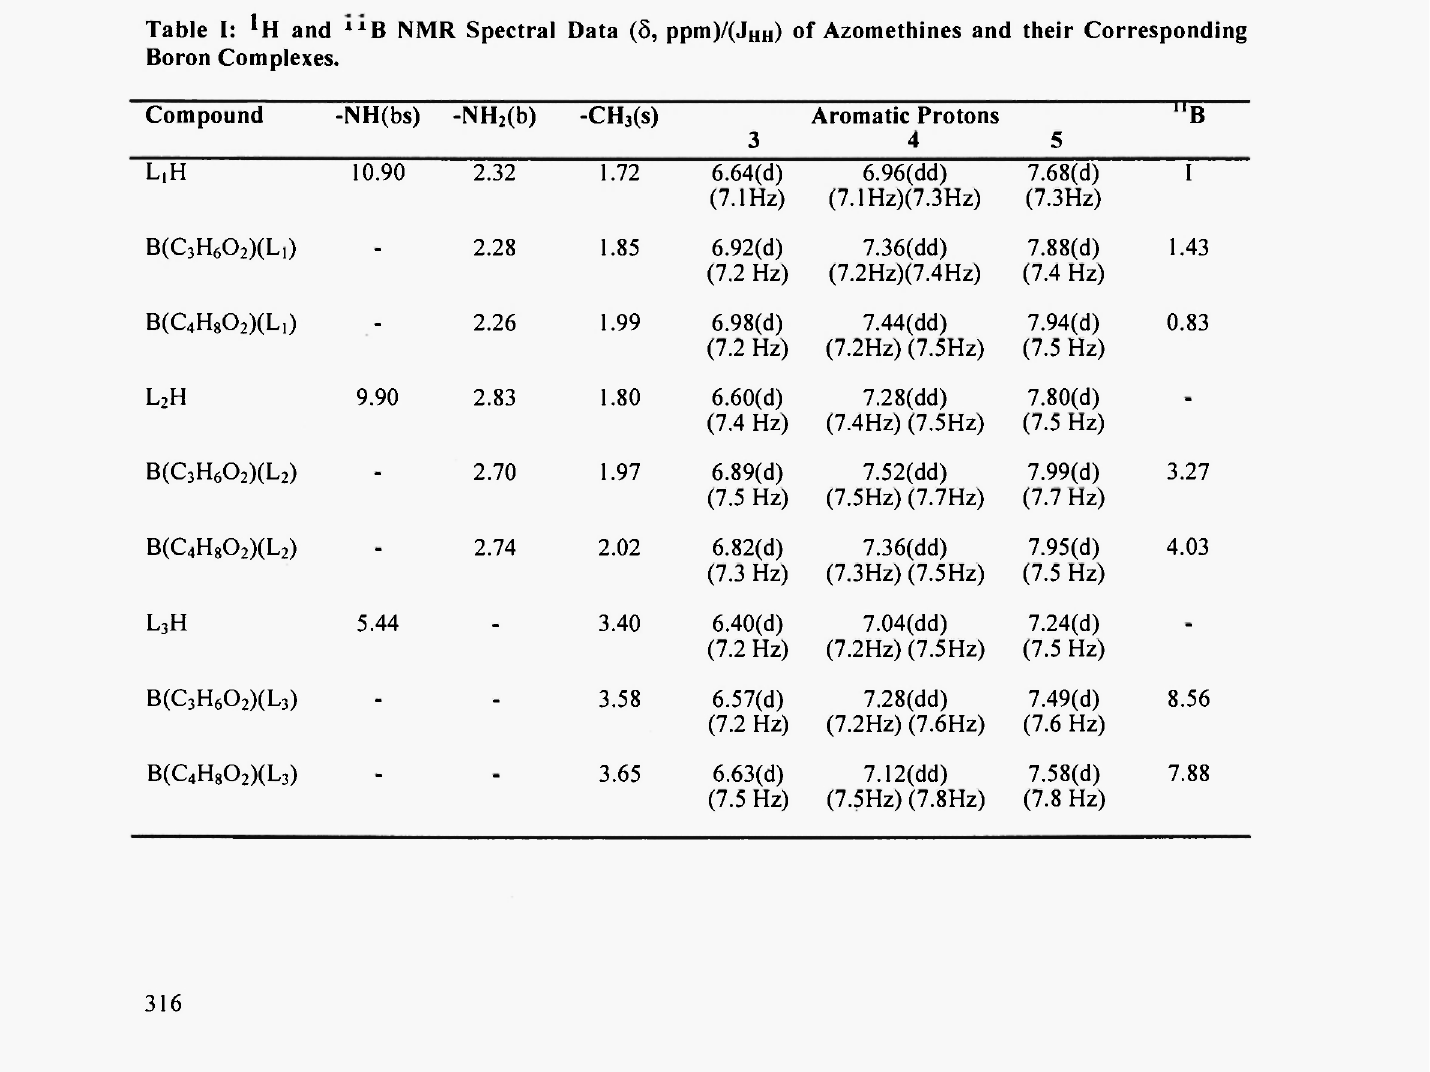
Table I: ^H and NMR Spectral Data (δ, ppm)/(J H H) of Azomethines and their Corresponding Boron